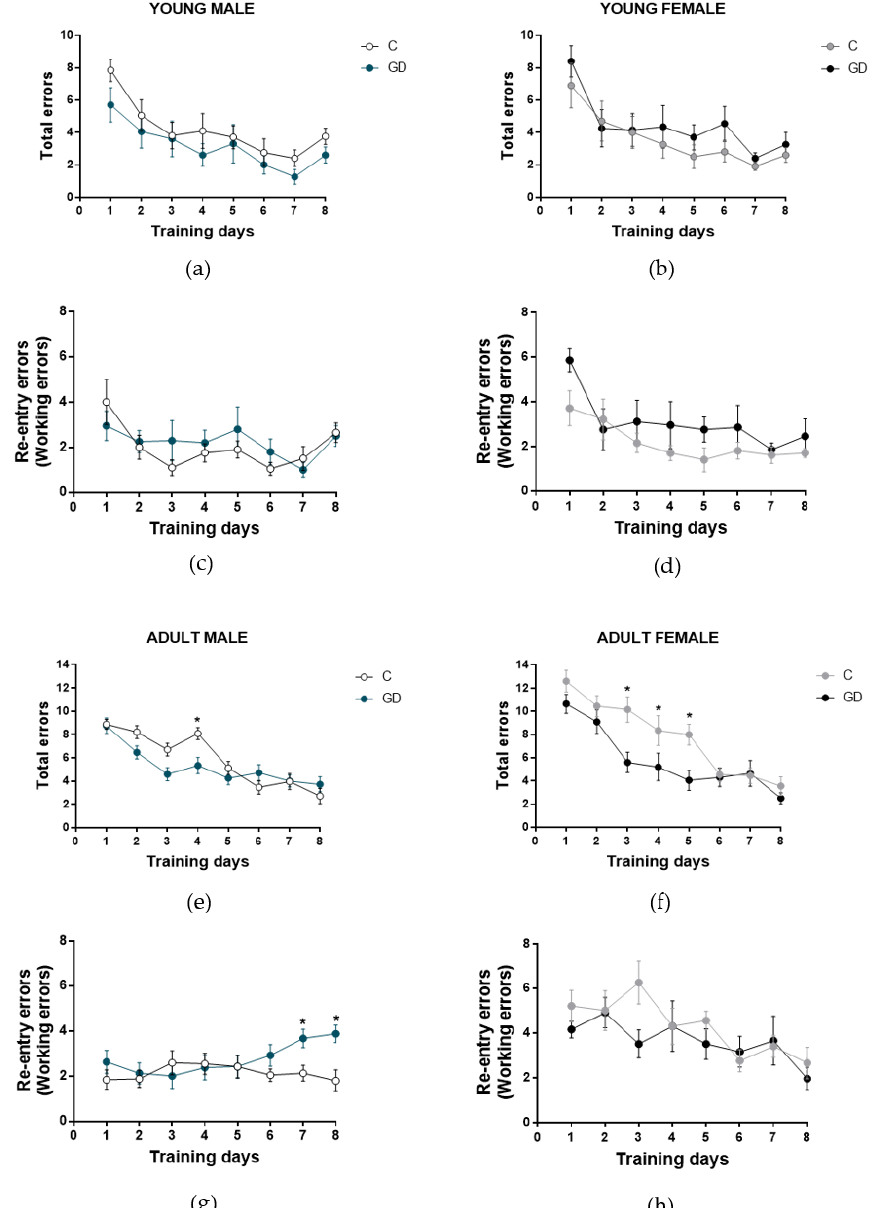
Figure 3. Effect of GD on the short-term memory of offspring, showing the total and reentry errors Figure 3. E ff ect of GD on the short-term memory of o ff spring, showing the total and reentry errors during the training days. The young male and female offspring total errors ( a , b ) and reentry errors during the training days. The young male and female o ff spring total errors ( a , b ) and reentry errors ( c , d ) respectively. The adult male and female offspring total errors ( e, f ) and reentry errors ( g, h ) ( c , d ) respectively. The adult male and female o ff spring total errors ( e, f ) and reentry errors ( g, h ) respectively. C, control offspring; GD, gestational diabetes offspring. Control male offspring: young, respectively. C, control o ff spring; GD, gestational diabetes o ff spring. Control male o ff spring: young, n = 10; adult, n = 12. GD male offspring: young, n = 10; adult, n = 12. Control female offspring: young, n = 10; adult, n = 12. GD male o ff spring: young, n = 10; adult, n = 12. Control female o ff spring: young, n = 10; adult, n = 10. GD female offspring: young, n = 10; adult, n = 10. Data are expressed as the mean n = 10; adult, n = 10. GD female o ff spring: young, n = 10; adult, n = 10. Data are expressed as the mean ± SEM. Two-way ANOVA of repeated measures and one- way ANOVA; post hoc Tukey’s test; * p < ± SEM. Two-way ANOVA of repeated measures and one-way ANOVA; post hoc Tukey’s test; * p < 0.05.